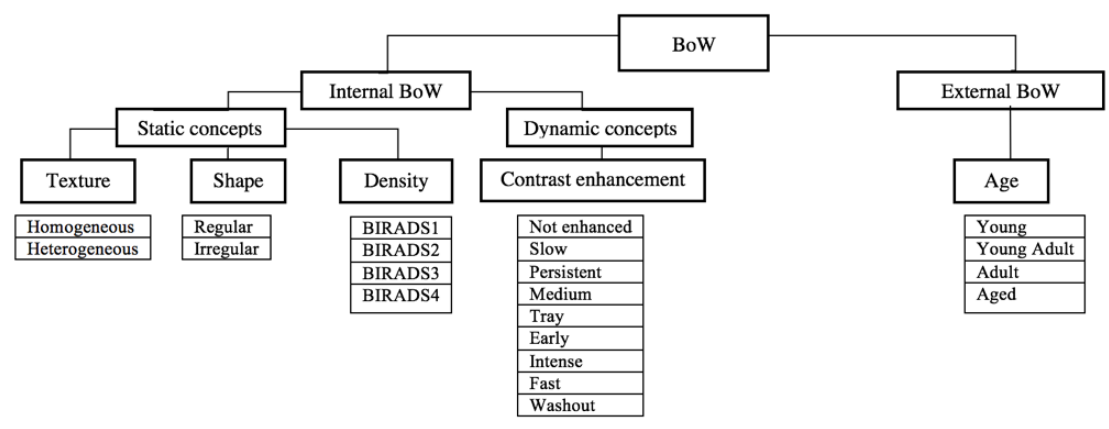
Figure 4. Bag of words set with respect to expert reasoning and